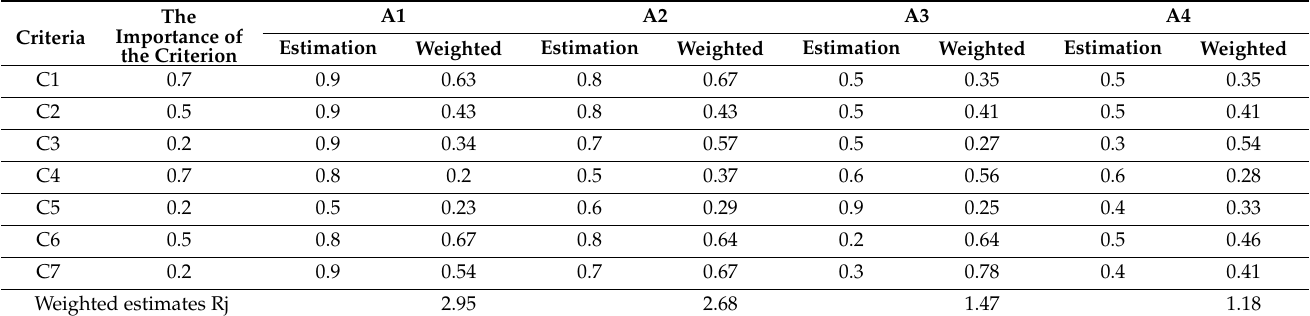
Table 6. Calculation of weighted estimates for each